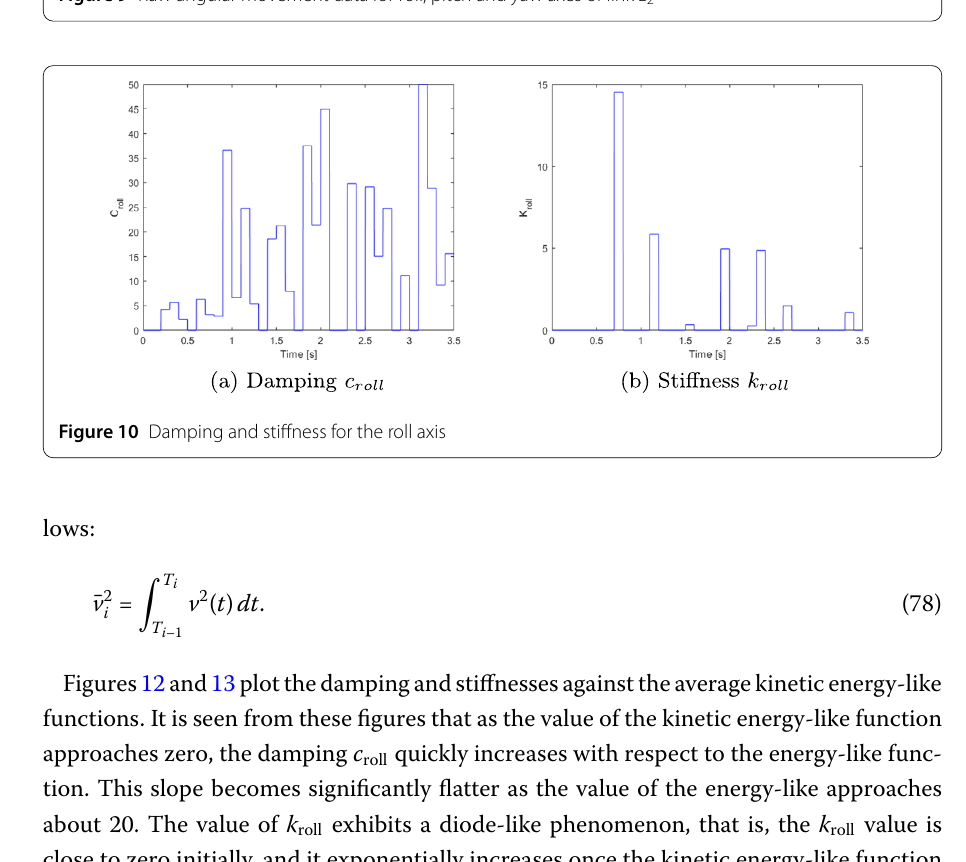
Figure 9 Raw angular movement data for roll, pitch and yaw axes of link L 2